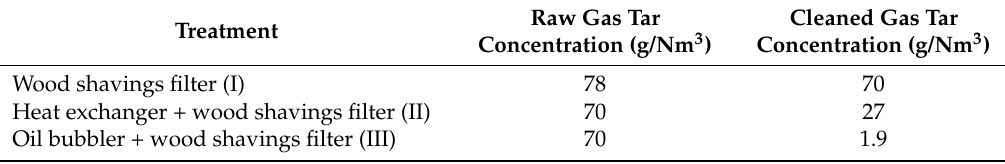
Table 3. Tar contents of raw and cleaned syngas (dry basis) with the three tar cleaning treatments.